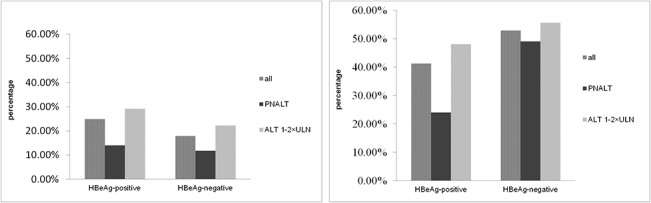
Distribution of significant necroinflammation and fibrosis among 300 chronic hepatitis B patients.(A) Significant necroinflammation (≥ G2) was found in 24.9%, 14.0% and 29.1% in all patients, PNALT (ALT ≤ 40 U/ml) and ALT 1–2×ULN subgroups in HBeAg-positive patients, and 17.9%, 11.8% and 22.2% in all patients, PNALT and ALT 1–2×ULN subgroups in HBeAg-negative patients, respectively. (B) Significant fibrosis (≥ S2) was found in 41.2%, 24.0% and 48.0% in all, PNALT and ALT 1–2×ULN subgroups in HBeAg-positive patients, and 52.9%, 49.0% and 55.6% in all, PNALT and ALT 1–2×ULN subgroups in HBeAg-negative patients, respectively. Frequencies of significant necroinflammation and fibrosis in HBeAg-positive patients with ALT 1–2×ULN were much higher than in patients with normal ALT (P < 0.05).